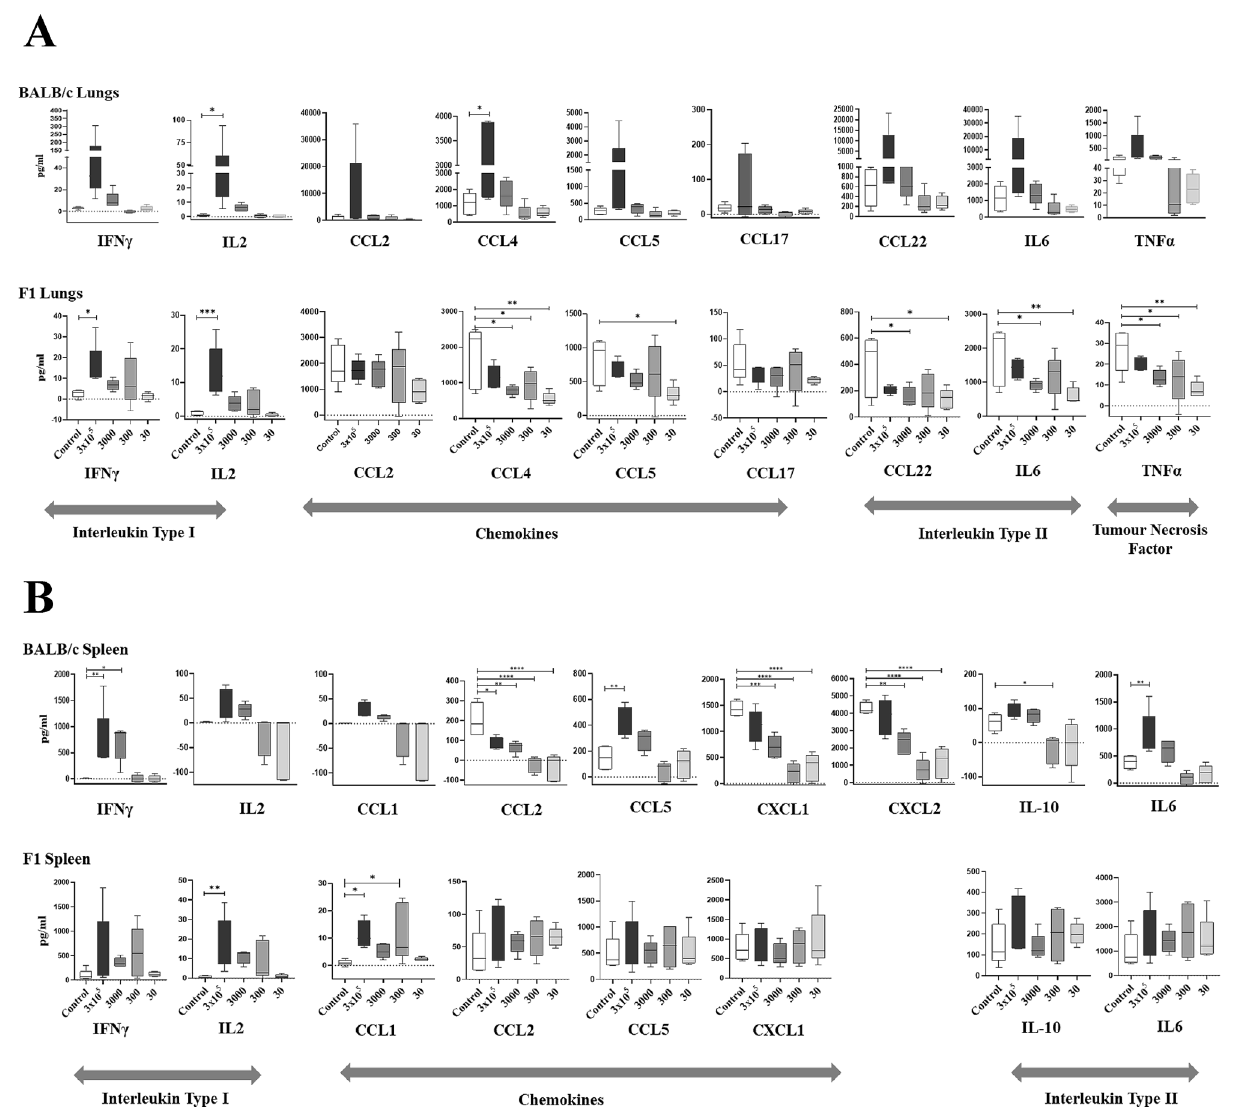
Figure 3. Cytokines/chemokines expression in the M7 stimulated the lung cells and splenocytes from BALB/c and CB6F1 mice vaccinated with various BCG doses. Data is the representative of one independent experiment for both strains of mice. Concentration of cytokines and chemokines were obtained using Luminex xMAP ® Technology. The concentration of each cytokine or chemokine (pg/ml) was obtained by subtracting concentration of M7-stimulated with the no antigen cells and used as data for graphs ( A and B ). A representative graph of cytokines/chemokines expressed in pg/ml after 3 days of stimulated lung cells (top graphs) splenocytes (bottom graphs) of BALB/c and CB6F1 mice for all groups. Bars representing mean (± S.E.) pg/ml. One-way ANOVA, Dunnett’s multiple comparison test, *ρ < 0.05, **ρ < 0.005, ***ρ < 0.0005 was performed for ( A and B